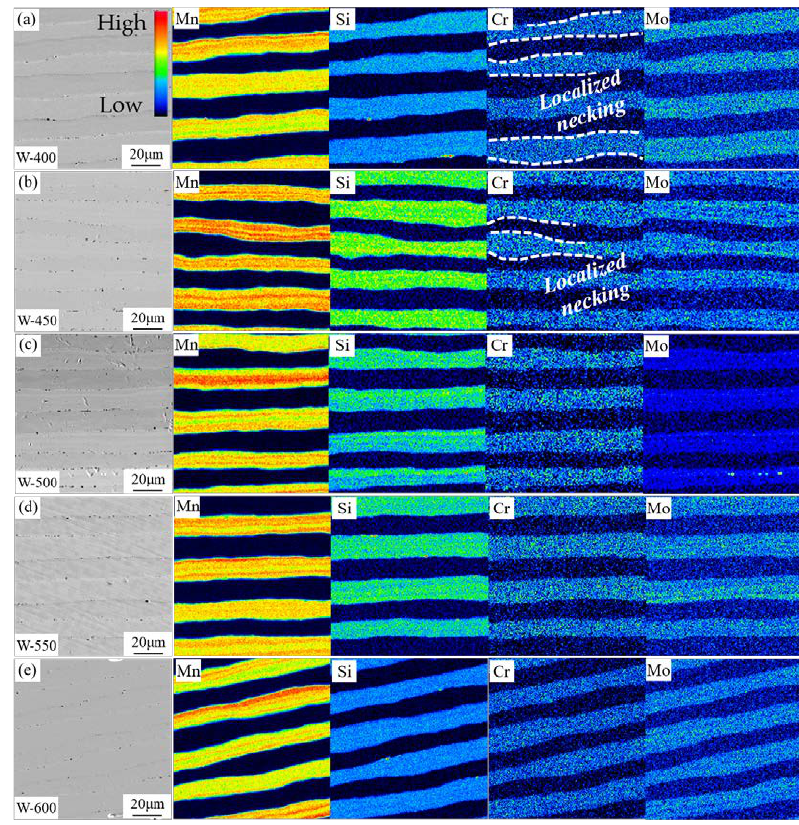
Figure 3. Elemental distribution of multi-layer composite steel at different rolling temperatures: ( a ) 400 °C; ( b ) 450 °C; ( c ) 500 °C; ( d ) 550 °C; ( e ) 600 °C.